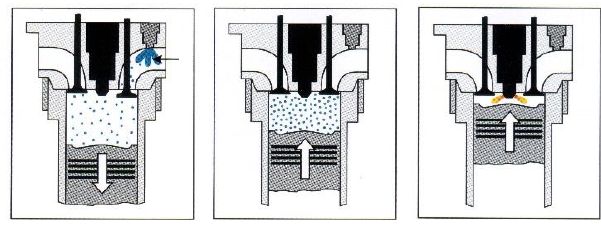
Fig. 4. Schematic drawing of direct dual-fuel injection engine work (re- produced from